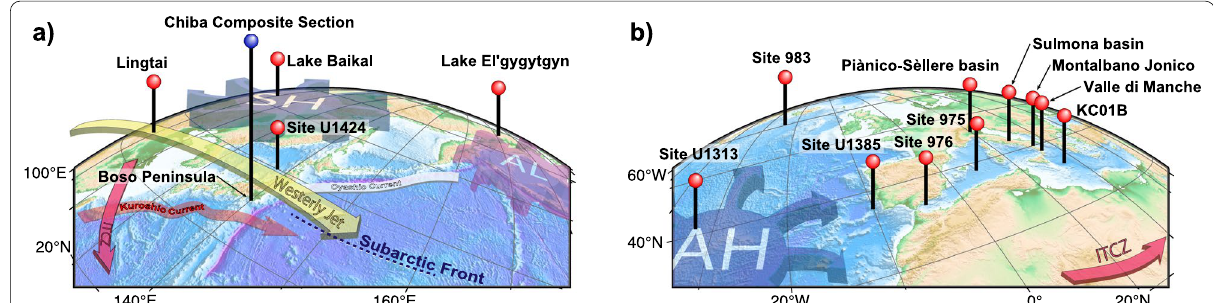
Fig. 1 Schematic representation of the climatic configurations in East Asia, and the Mediterranean and North Atlantic Ocean. Locations of the Chiba composite section and other important sites discussed in this special issue are shown. Atmospheric systems are abbreviated as follows. SH Siberian High, AL Aleutian Low, ITCZ intertropicalconvergence zone, AH Azores